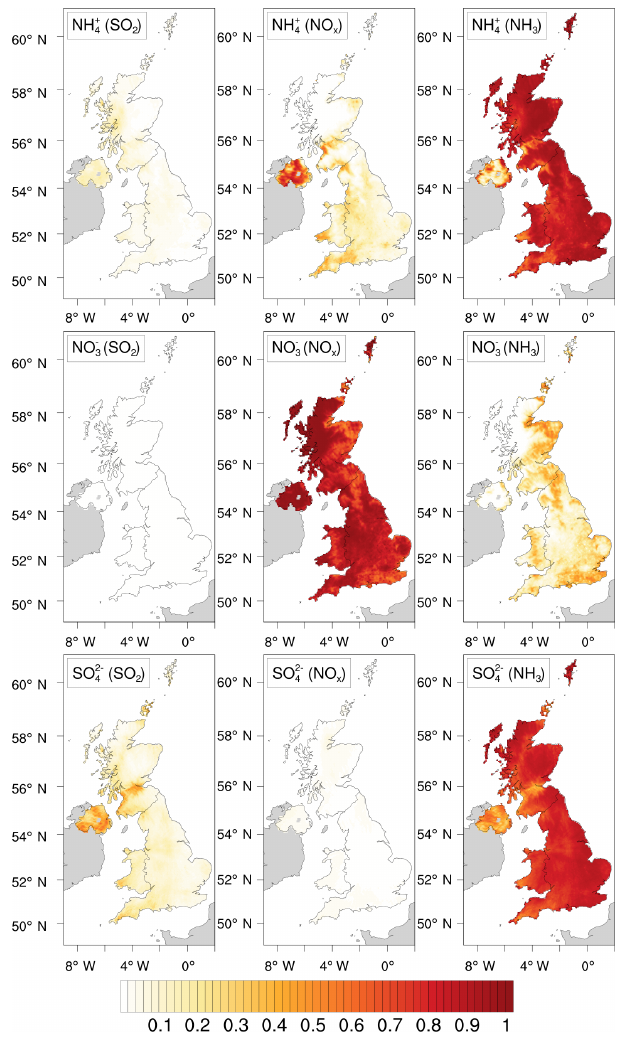
Figure 6. Spatial distributions (at the 5km × 5km model grid res- olution) of the squared SRC values which represent the fractional contribution of the uncertainty in the input emissions given in brack- ets to the overall uncertainty in the surface concentrations of partic- ulate NH + , SO 2 − , and NO − . The uncertainties in the input emis- 4 4 3 sions are ± 4, ± 10, and ± 20% for SO 2 , NO x , and NH 3 respec- tively.